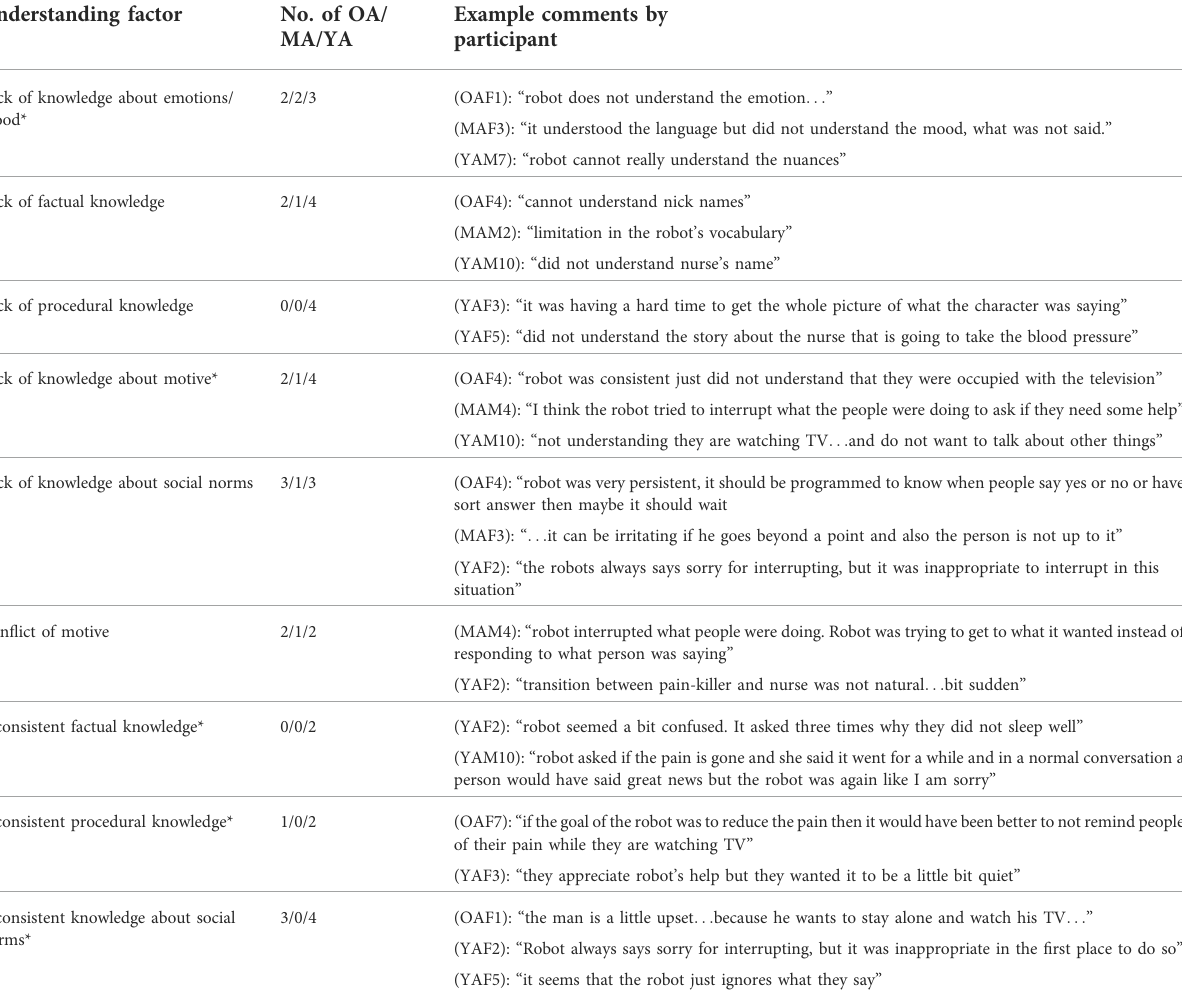
TABLE 3 Understanding: the fi rst column lists the factors relating to understanding. The second column shows how many older adults (OA), middle- aged (MA) adults, and younger adults (YA) identi fi ed breakdown situations categorized as a particular factor. The factors identi fi ed by the participants not explicitly embedded in the design of the scenarios are marked with an asterix